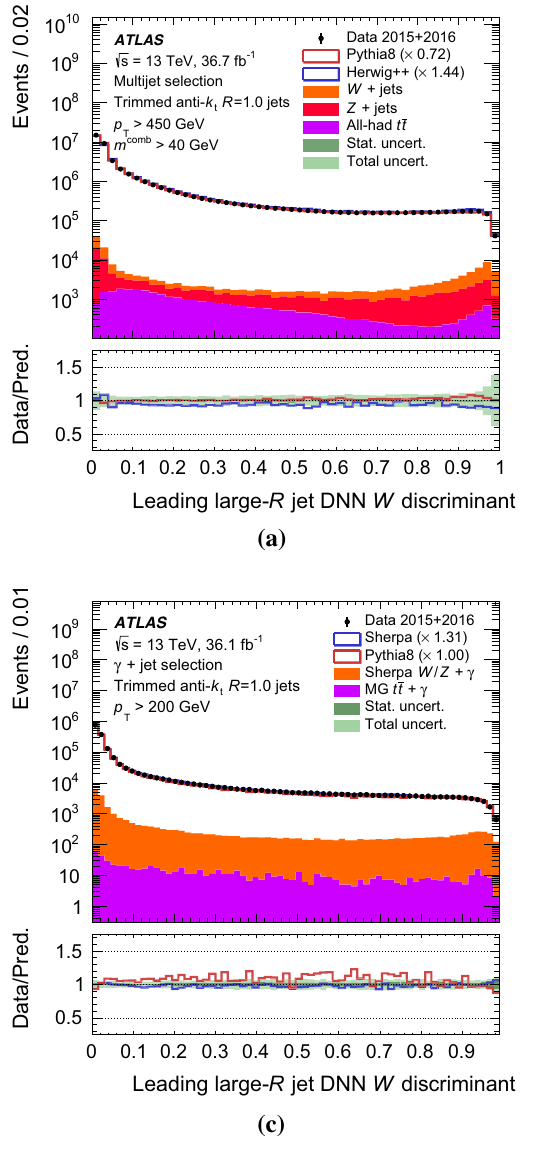
shown in the legend beside the specific sample to which it applies. Sys- tematic uncertainties are indicated as a band in the lower panel and include all experimental uncertainties related to the selection of events, as well as the reconstruction and calibration of the large- R